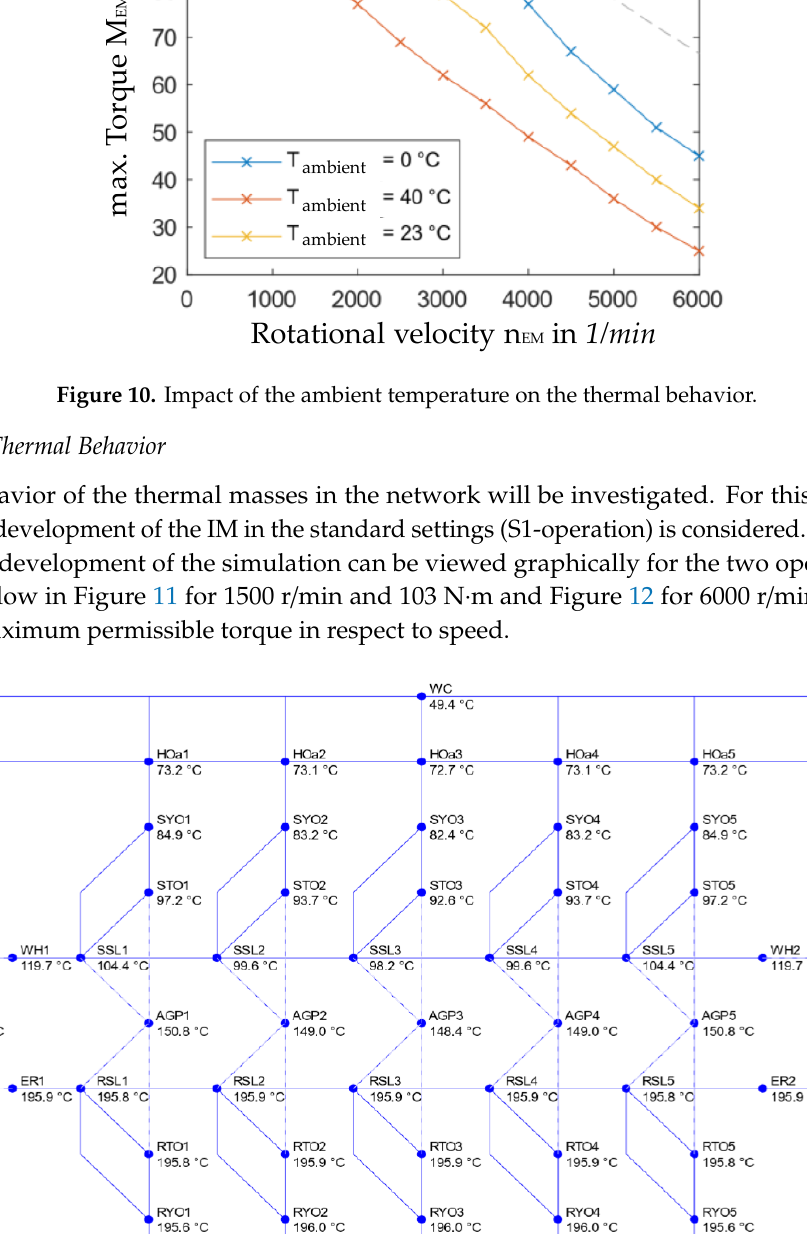
12 of 16 Figure 9. Simulative overload potential of the IM for the NEmo. 5.2. Effect of Ambient Temperature on Thermal Behavior of Machine For the variation, the two ambient temperatures, a range between 0 and 40 °C, are considered. The density of the air 𝜌 air at the regarded minimum and maximum temperature is 1.276 and 1.023 kg ⋅ m −3 , respectively [30]. For 0 °C, the simulation of the WLTC cycle results in a specific energy requirement of the electric machine of 10.4 kWh/100 km. In order to separately measure the effect of reduced air resistance at 40 °C ambient temperature, a second simulation is carried out with the air density reduced to 1.023 kg ⋅ m −3 . This results in a specific energy requirement of 9.3 kWh/100 km. The lower air resistance thus ensures a consumption saving of 11.1%. During S1-operation, the increased temperature is accompanied by a significantly reduced maximum torque over the entire speed range. Figure 10 shows the characteristic curves for 0, 23 and